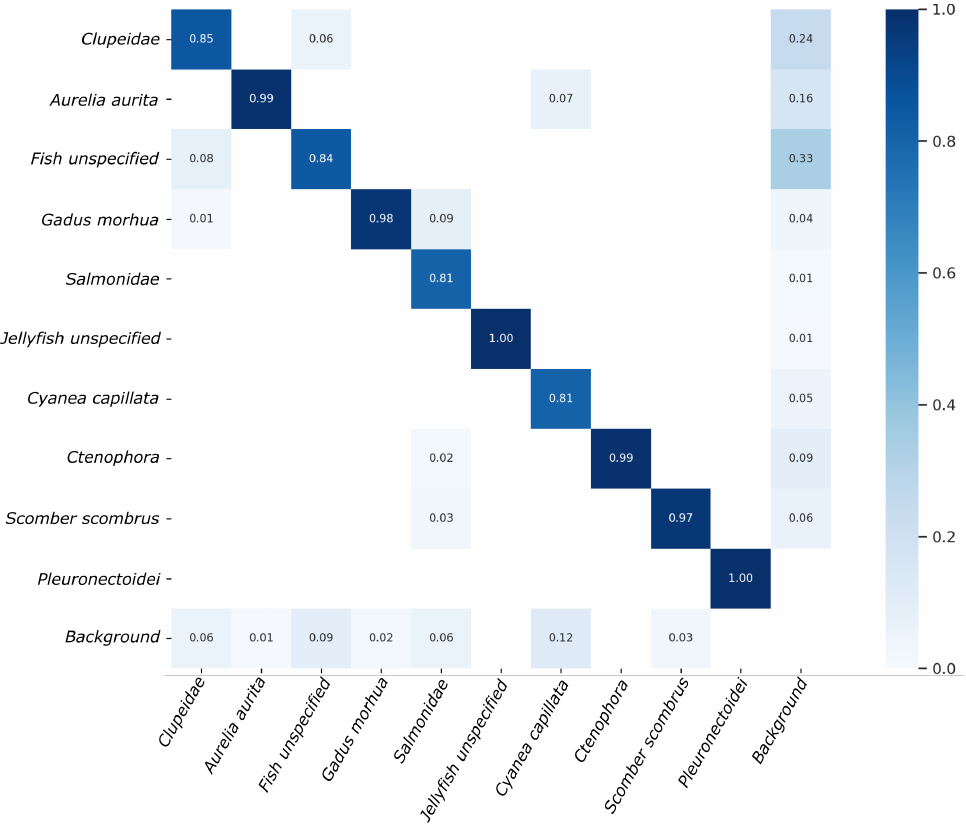
Figure 8. Confusion matrix of the detection results obtained on validation